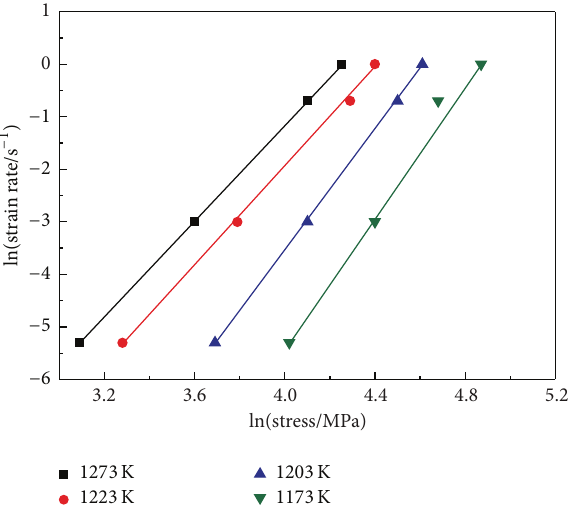
Figure 5: The relationships between ln ̇𝜀 and ln [ sinh (𝛼𝜎)] .